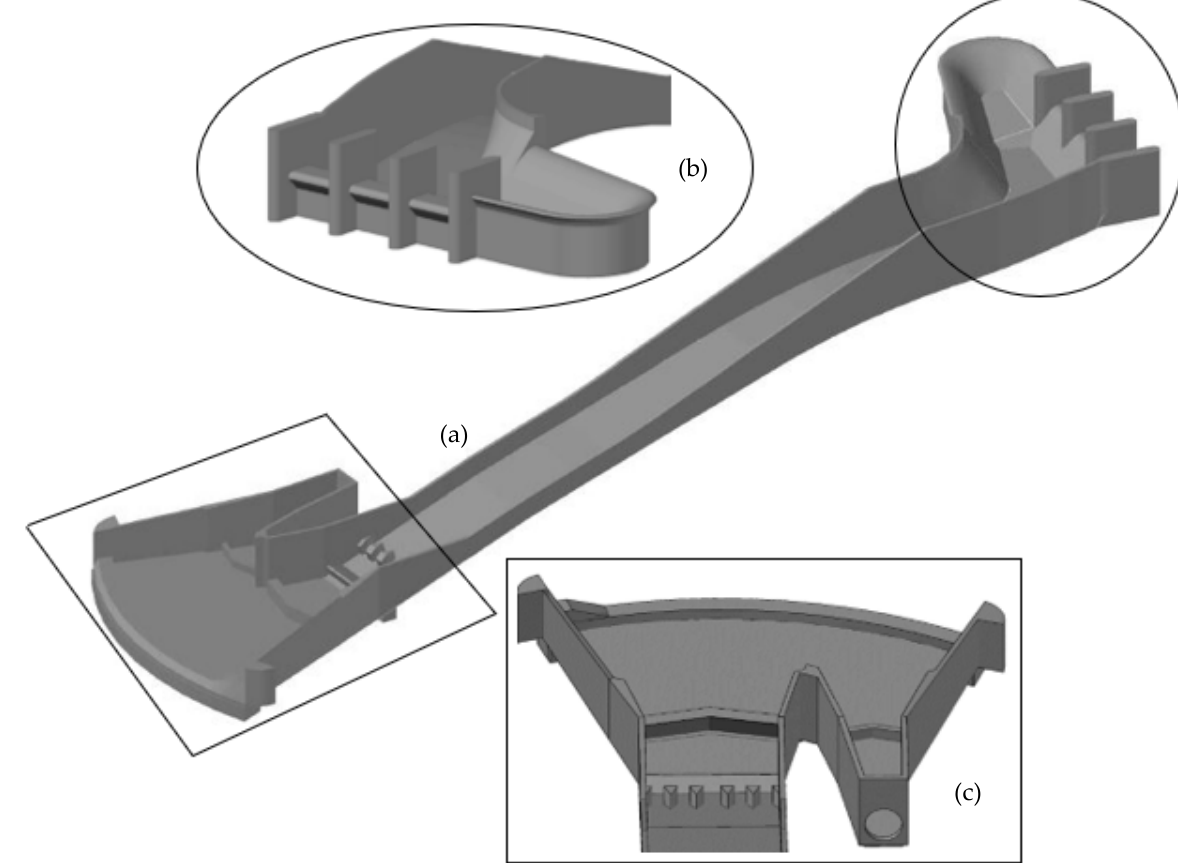
Figure 6. ( a ) Three-dimensional drawing of the infrastructure in the model scale carried out with AutoCAD; ( b ) AutoCAD model of the surface spillway; and ( c ) AutoCAD model of the stilling basin.